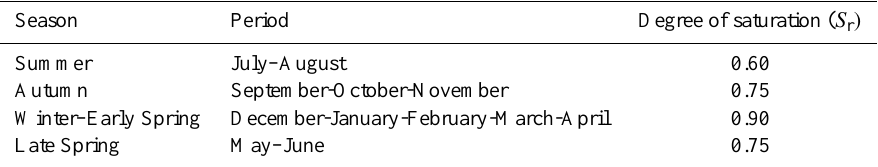
Table 3. Values of the degree of saturation used in the SLIP